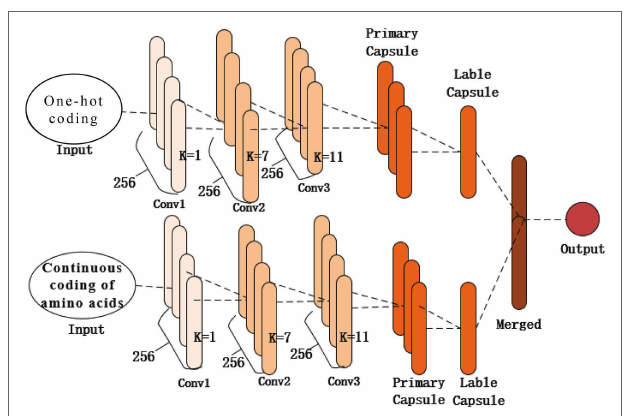
FIGURE 2 | Network structure of the proposed